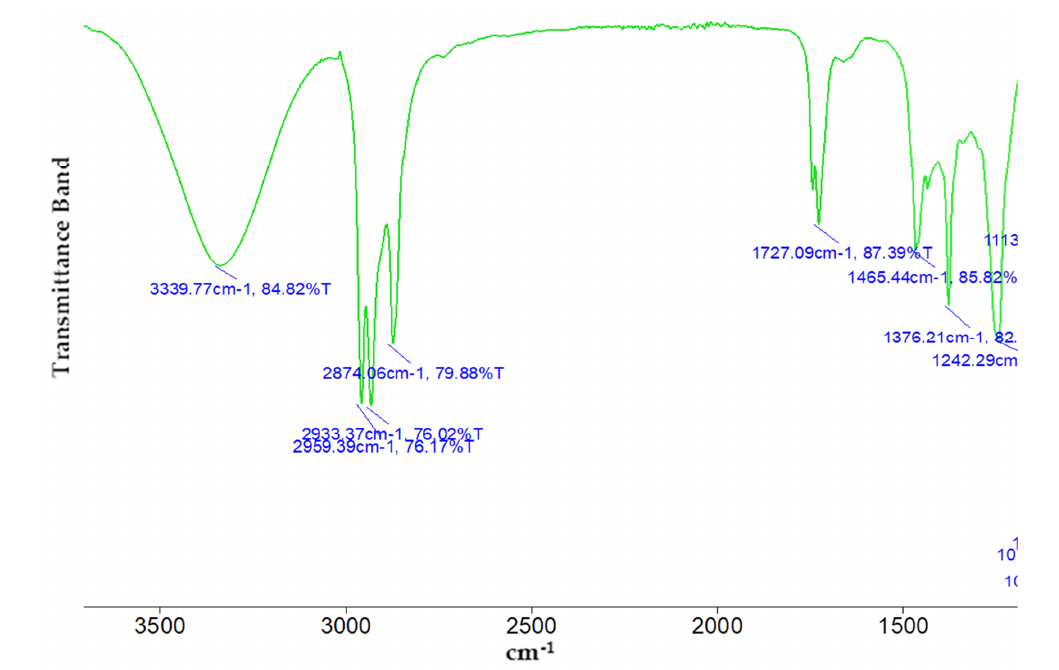
Figure 3. FTIR spectrum analysis of the methanolic extract of the T. vulgaris plant.